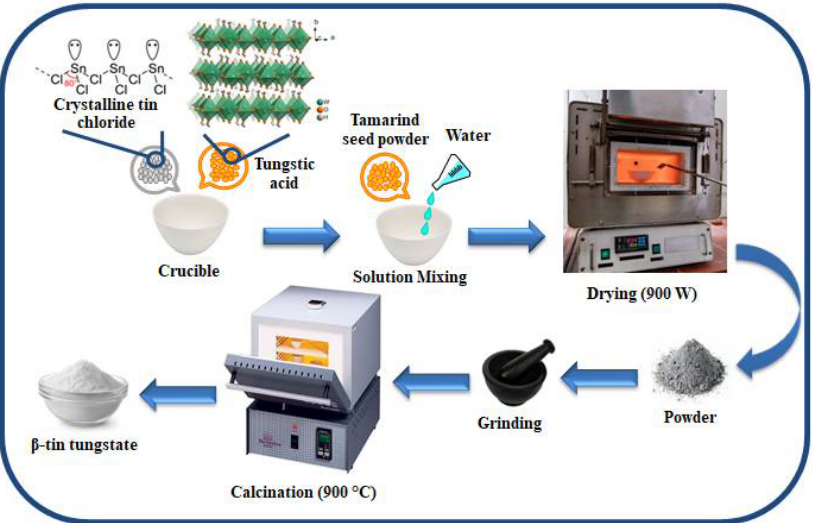
Figure 1. Schematic illustration of the sample synthesis.